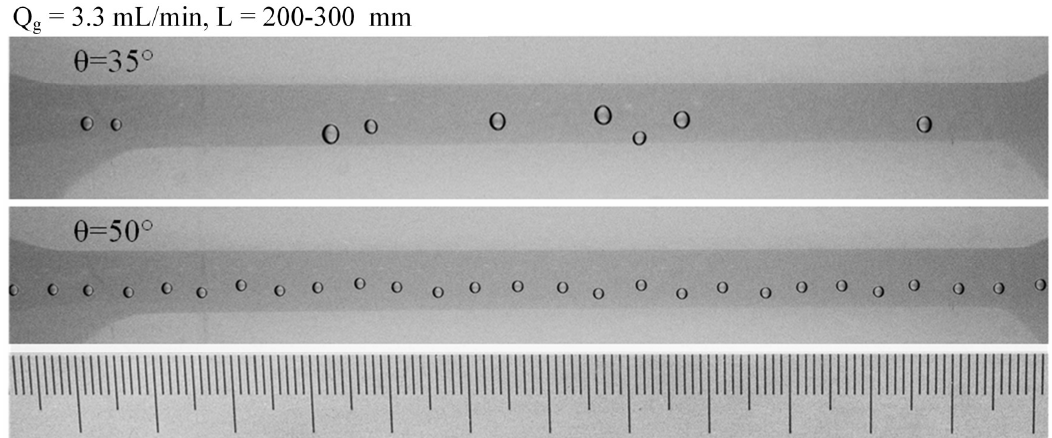
Figure 5. Bubble movement in modes without cluster formation (θ = 35°) and with cluster formation (θ = 50°); gas flow rate Q g = 3.3 mL/min.